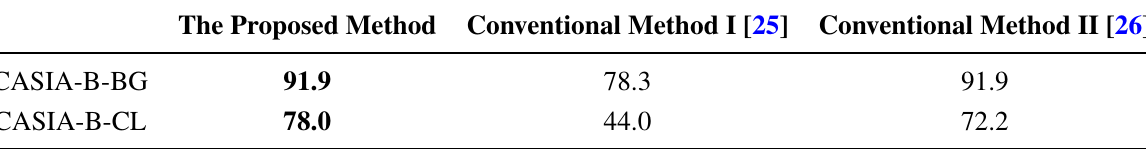
Table 4. Comparison of the proposed method with the conventional methods [25,26][ %